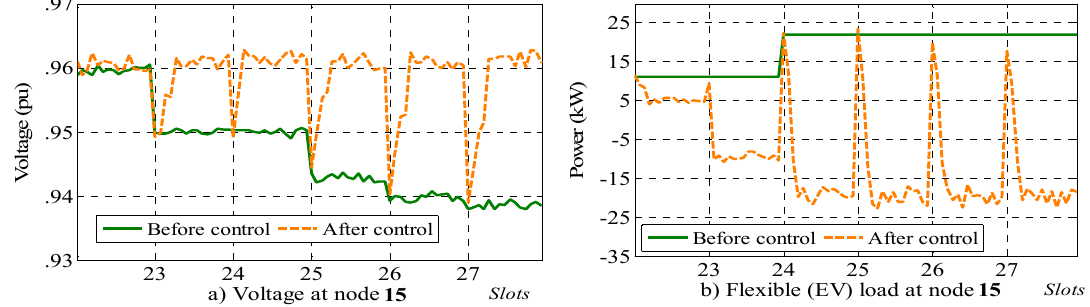
Figure 15. Adaptive variation of power per real-time monitored voltage.